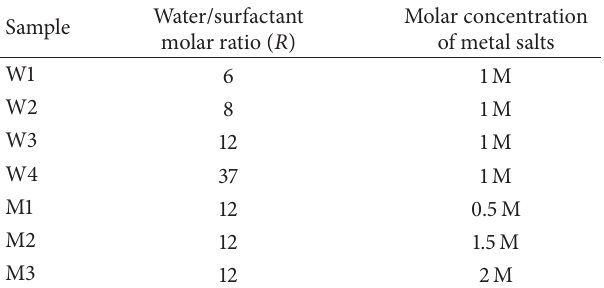
Table 1: Samples and process